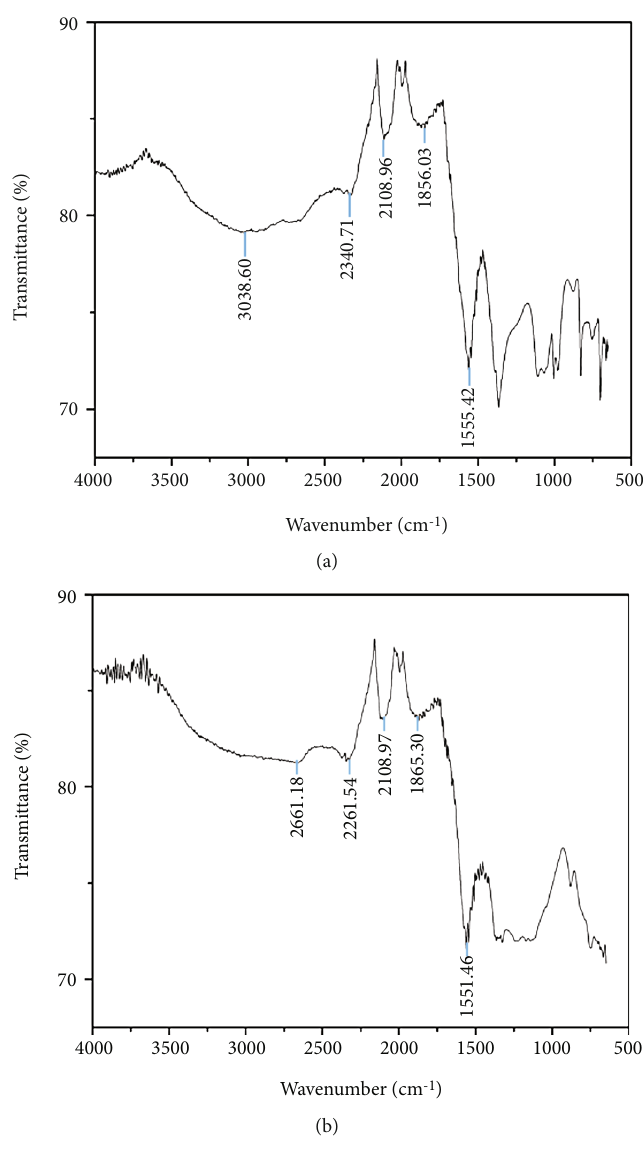
Figure 9: FTIR analysis for BC500 (a) before and (b) after the MB